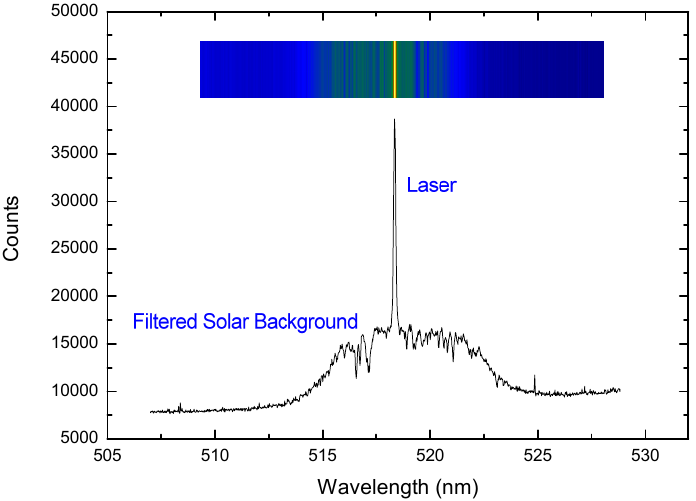
Figure 5. Laser transmitter spectrum and sky background with Fraunhofer lines structure.